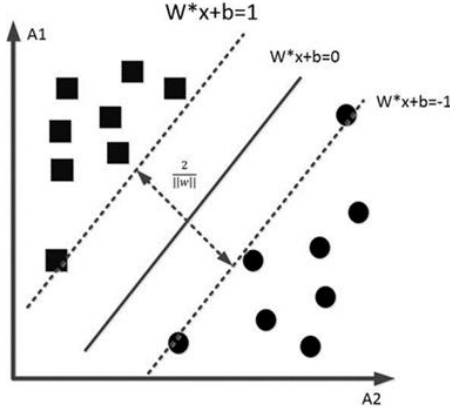
Figure 9. Principle of the SVM classifier .